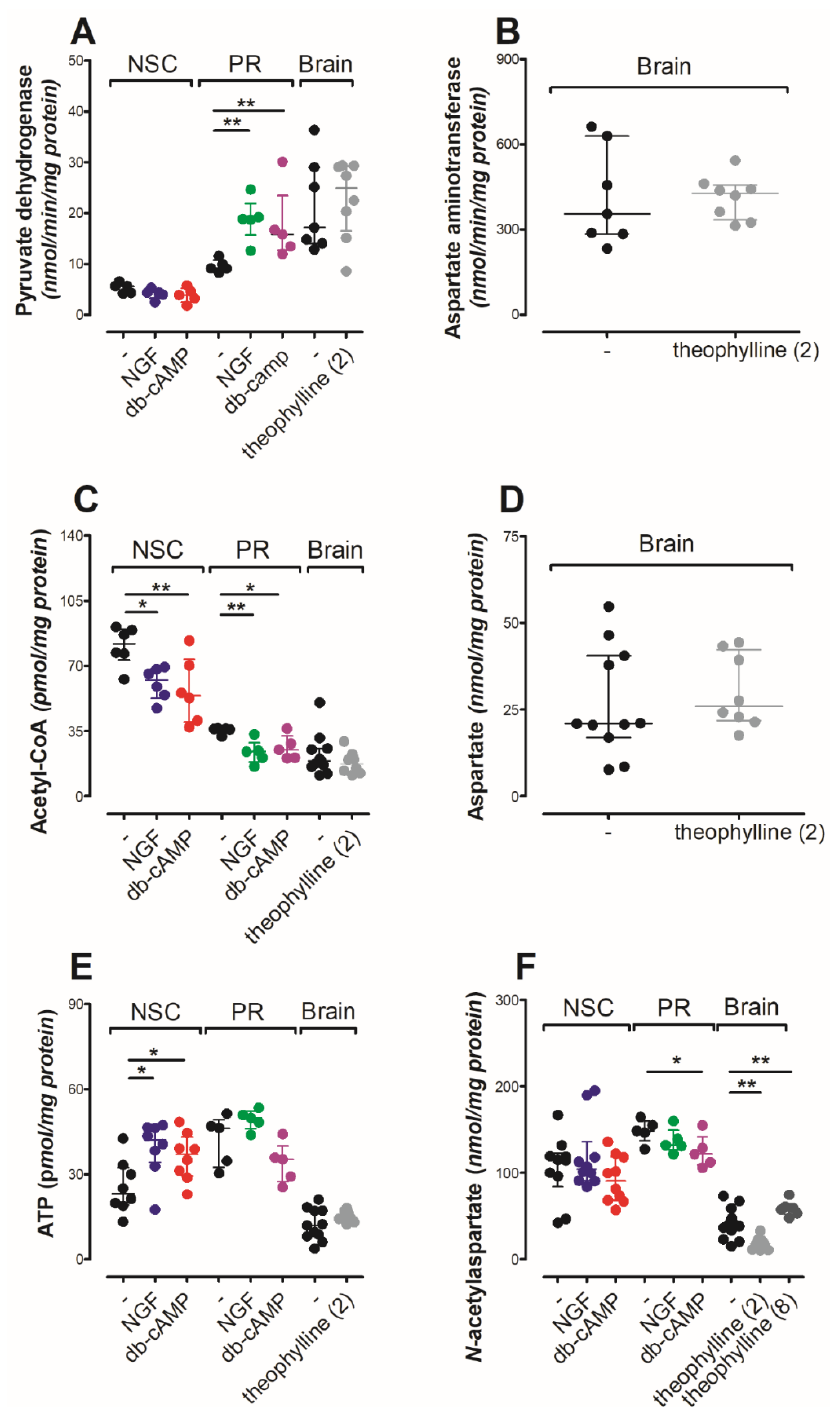
Figure 4. Impact of differentiation factors on NAA-related markers. ( A ) Pyruvate dehydrogenase activity; ( B ) aspartate aminotransferase activity; ( C ) acetyl-CoA level; ( D ) aspartate level; ( E ) ATP level; ( F ) N -acetylaspartate level. Results are showed as medians with interquartile ranges from 5–10 observations per group. Significantly different from the control: * ( p -value < 0.05), ** ( p -value < 0.01). Abbreviations: db-cAMP: dibutyryl-cyclic AMP, NGF: nerve growth factor, NSC: neural stem cells; PR: primary neurons; theophylline (2): 2 weeks theophylline treatment; theo- phylline (8): 8 weeks theophylline